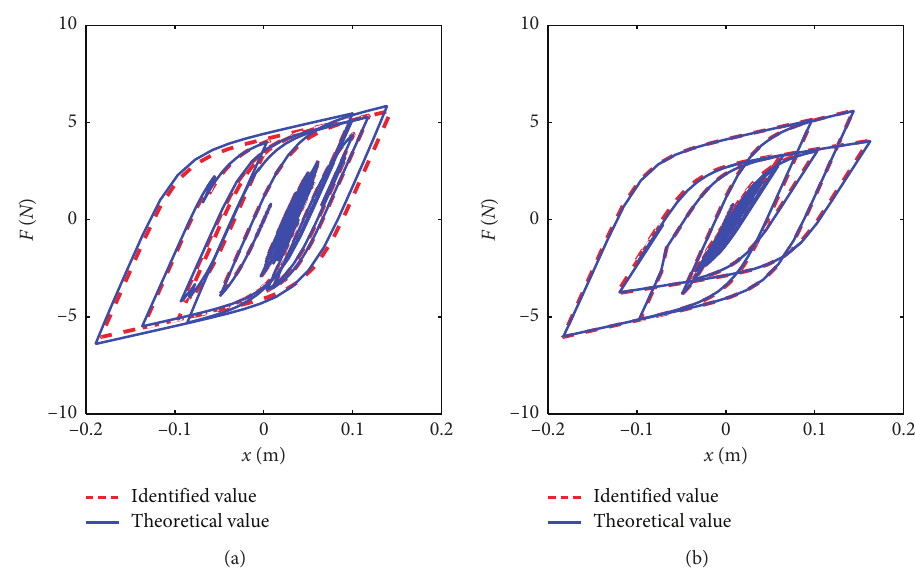
Figure 20: Comparison of hysteresis loops under Kobe earthquake wave. (a) Case 1. (b) Case 2.